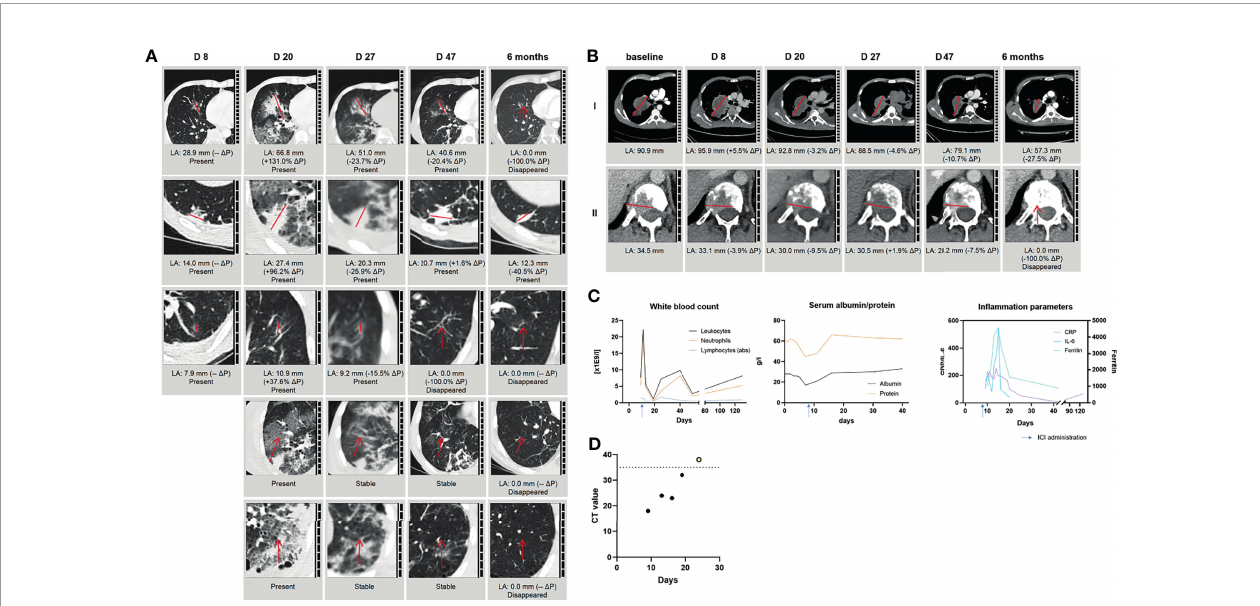
FIGURE 1 | Radiologic examinations and laboratory assessments after initiation of pembrolizumab-based treatment during active COVID-19. (A) Exemplary pulmonary in fi ltrations during SARS-CoV-2 disease course and treatment with pembrolizumab with ground glass in fi ltration (I+III), consolidation (II), and mixed ground glass and consolidation (IV+V); (B) change of the tumor target lesions (I) right upper lobe/hilus and (II) TH12 during SARS-CoV-2 disease course and treatment with pembrolizumab; (C) blood counts, in fl ammatory markers, and serum albumin/protein. (D) SARS-CoV-2 viral load re fl ected by Ct value of SARS-CoV-2 PCR from sequential nasopharyngeal swabs. LA, largest diameter; D P, change from previous assessment; DX, day in relation to fi rst SARS-CoV-2 detection by PCR (=D0); CRP, C-reactive protein; IL-6, interleukin 6; LOD, level of